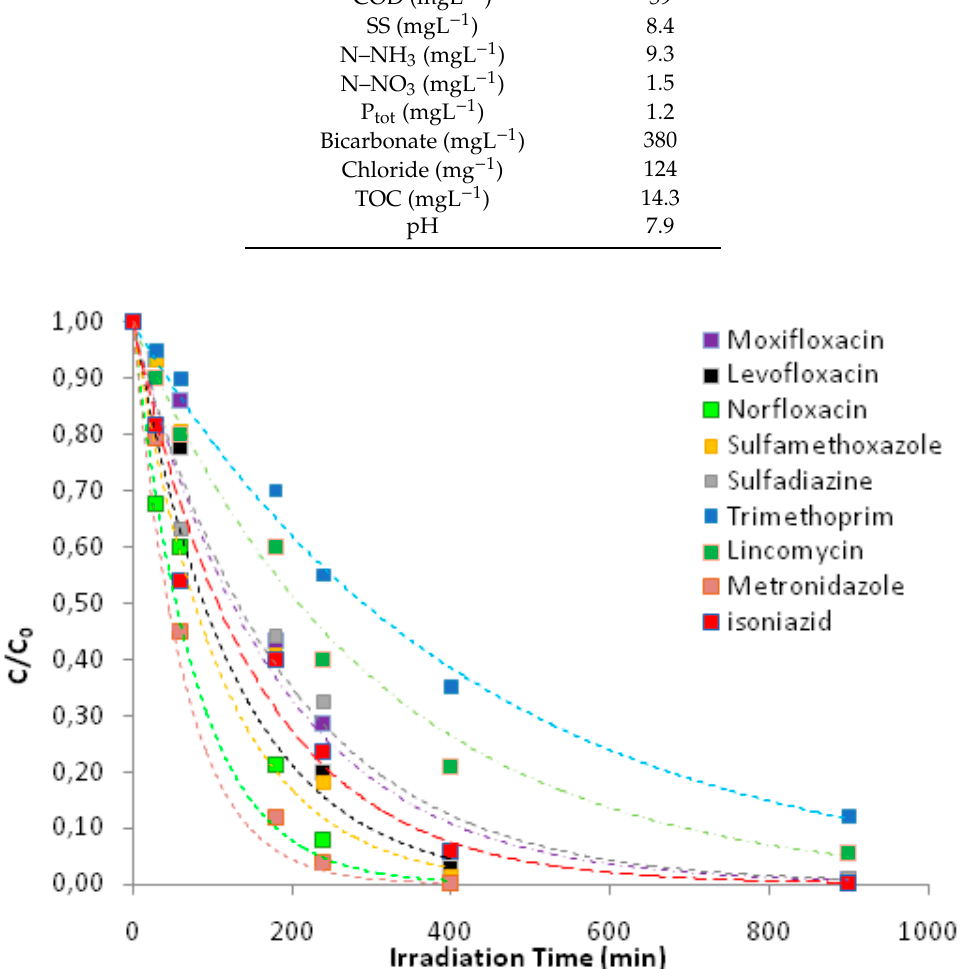
Figure 12. Photocatalytic degradation of the antibiotics mixture in the presence of PLLA–GO–50 wt% TiO 2 composite films in a wastewater effluent (C 0(drug) = 1 mgL –1 , PLLA–GO–50 wt% TiO 2 = 1 gL –1 , I = 750 Wm 2 ). Table 5. Kinetic data of the photocatalytic degradation of antibiotic mixture in wastewater e ffl